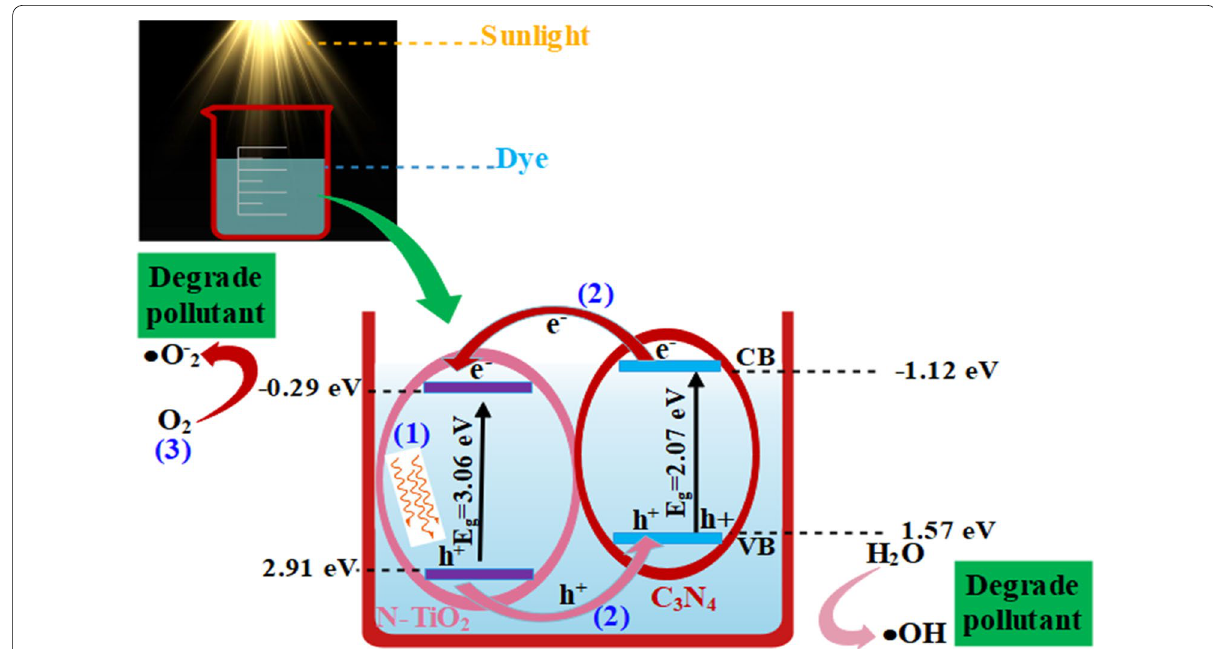
Fig. 7 Mechanism for degradation of dyes in the presence of prepared